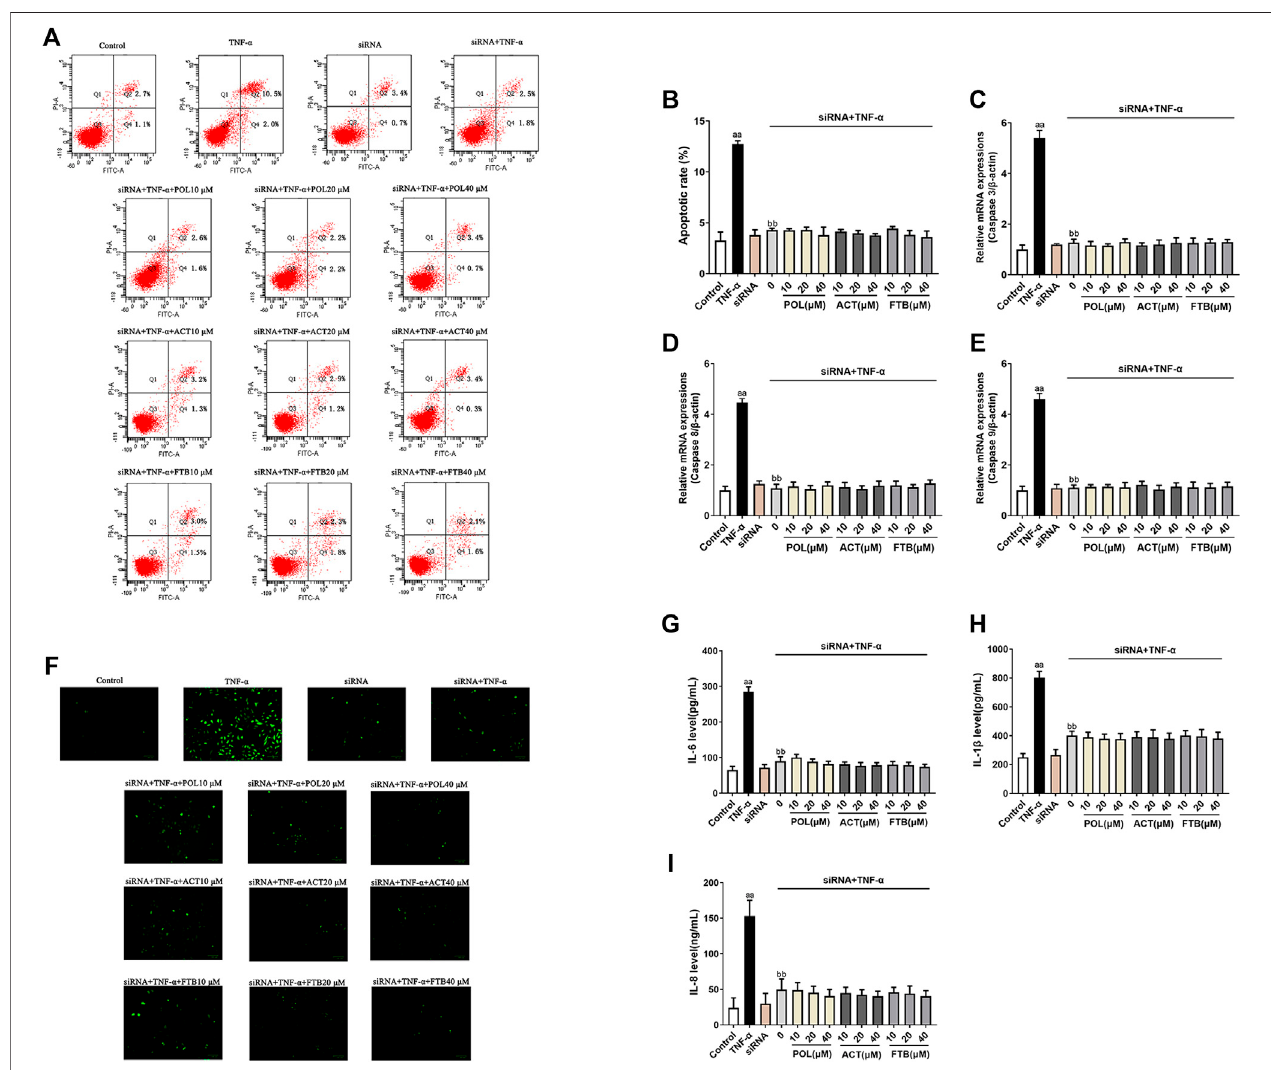
FIGURE 6 | Effects of POL, ACT, and FTB on TNF- α -induced apoptosis, ROS levels, and expression levels of cytokines following Nrf2 and NF- κ B p65 siRNA knockdown. (A,B) EffectsofPOL,ACT,andFTBonTNF- α -inducedapoptosisfollowingNrf2andNF- κ Bp65siRNAknockdown (C – E) RelativemRNAexpressionlevels of Caspase 3, Caspase 8, and Caspase 9. (F) Effects of POL, ACT, and FTB on the TNF- α -induced ROS level following Nrf2 and NF- κ B p65 siRNA knockdown. Scale bar indicates 100 μ m (G – I) Effects of POL, ACT, and FTB on TNF- α -induced IL-1 β , IL-8, and IL-6 levels following Nrf2 and NF- κ B p65 siRNA knockdown. Values represent means ± SD ( n (cid:2) 3-6). aa P < 0.01 vs control, bb P < 0.01 vs TNF- α .